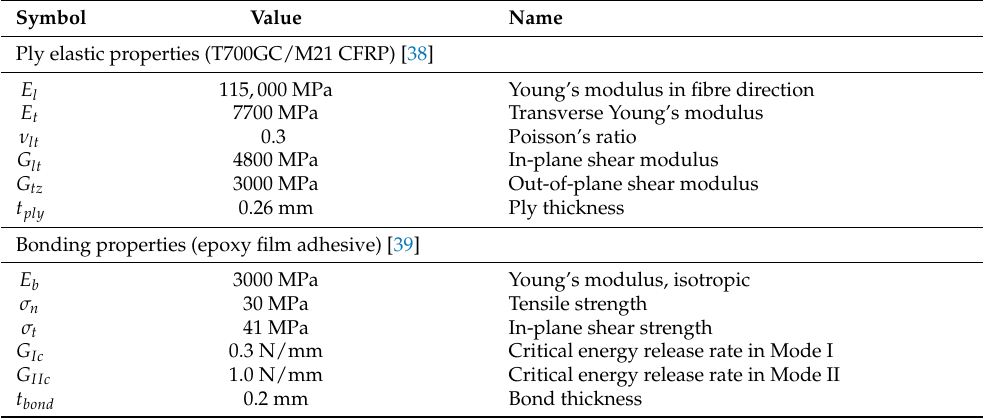
Table 1. Material properties used for numerical